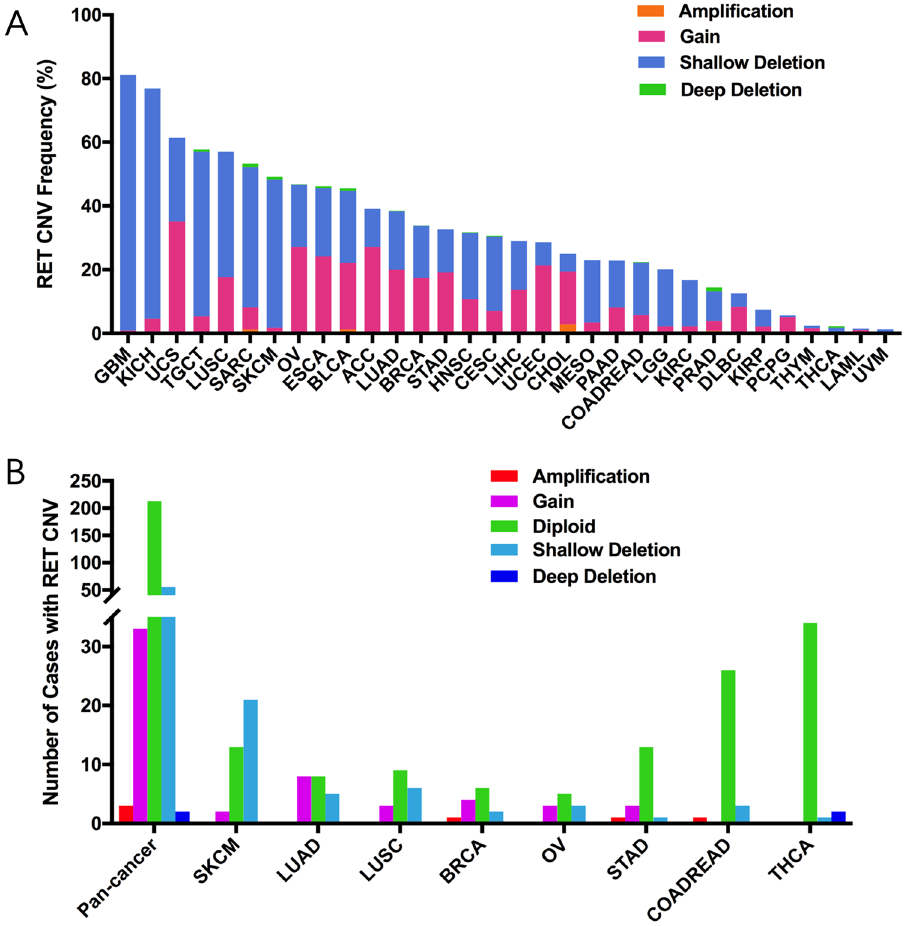
Figure 5. RET CNVs distribution among TCGA cancers. ( A ) The frequency of RET CNVs across 32 types of TCGA cancers. ( B ) The distribution of RET CNV in pan cancer and the top 8 cancer types. CNVs copy number